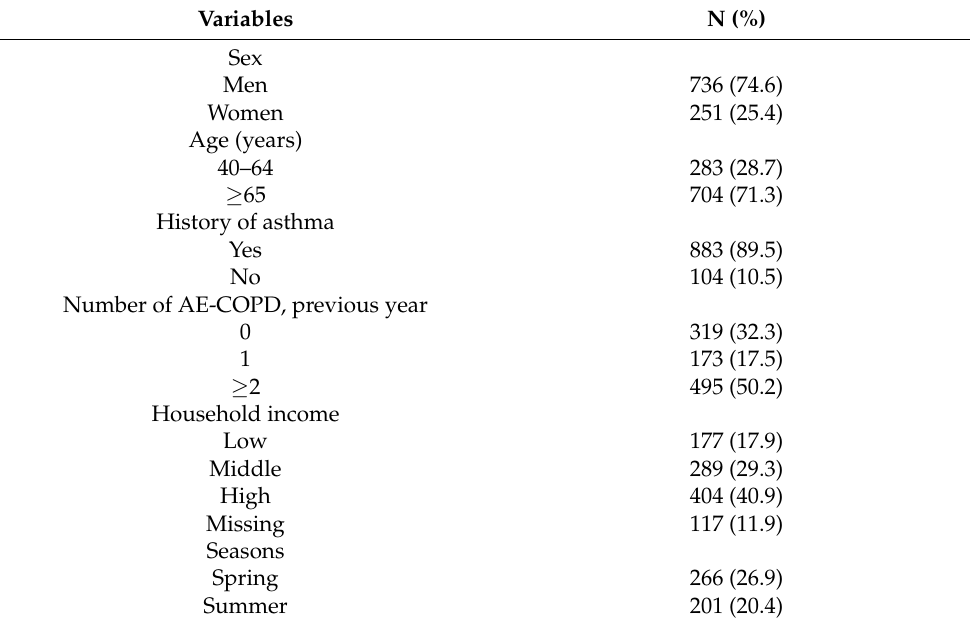
Table 1. General characteristics of hospital visits for acute exacerbation of chronic obstructive pulmonary disease in seven metropolitan cities in South Korea,